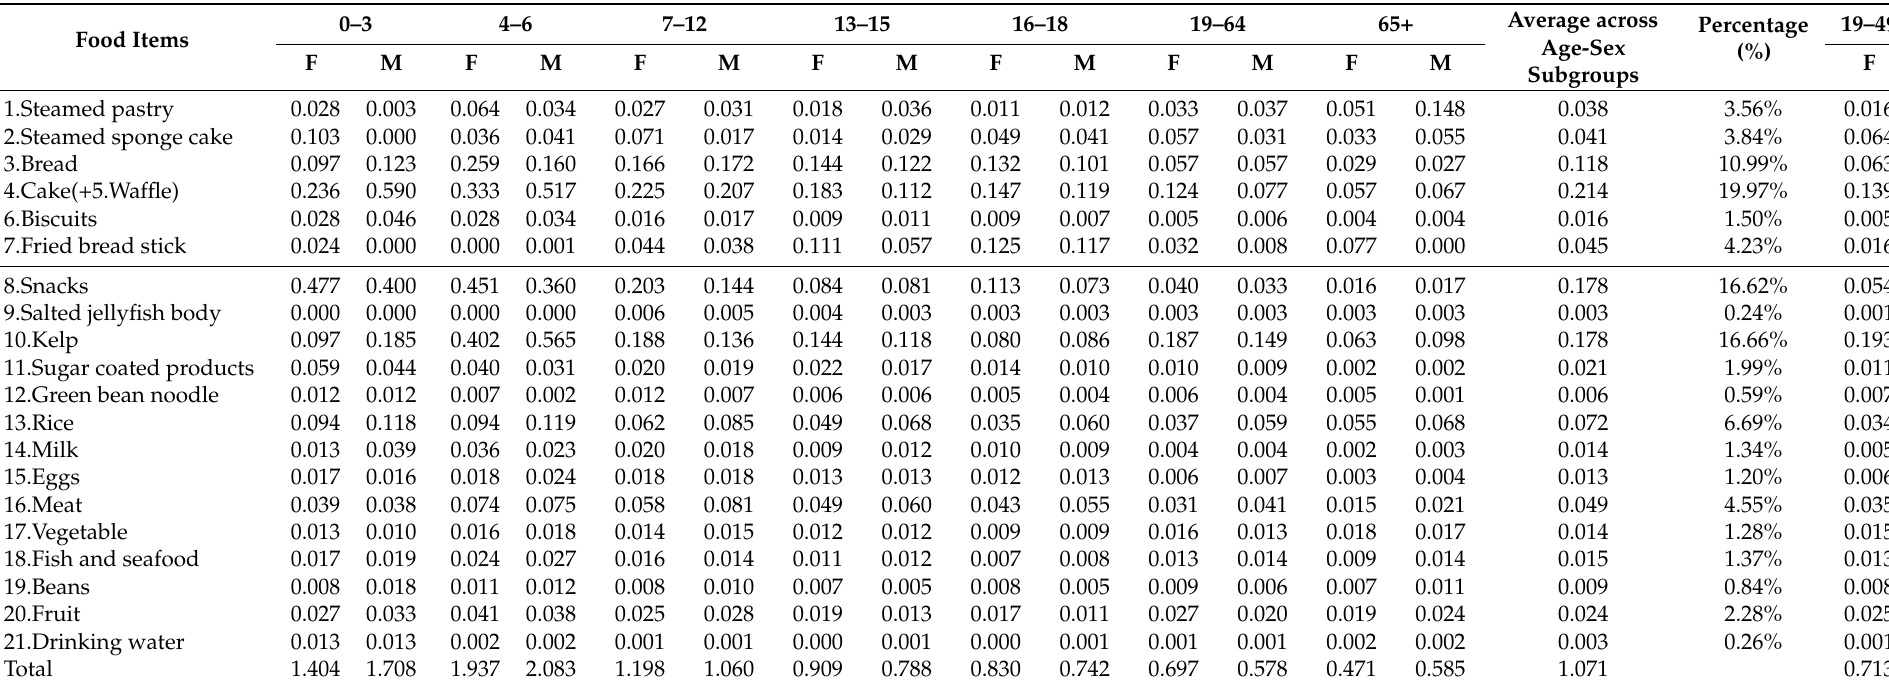
Table 2. Estimated weekly intake (EWI) (mg/kg-bw/wk) for all age-sex groups. Contribution percentages (%) for each food group are also presented. The definition of